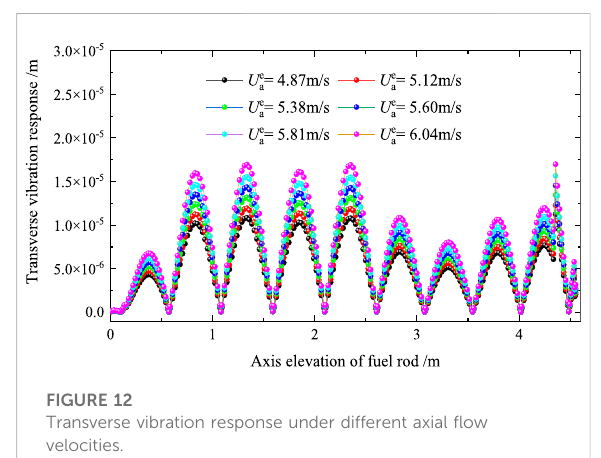
TABLE 7 Axial fl ow velocity.